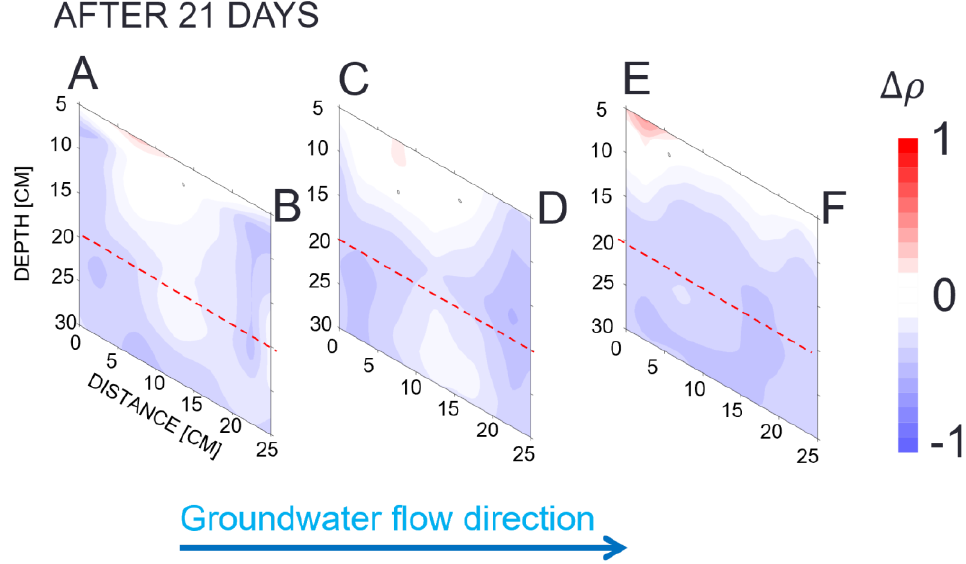
Figure 4. CHERTs after 21 days from the contamination. It is clear a sharp increase in conductivity values concerning the saturated zone below the groundwater table.